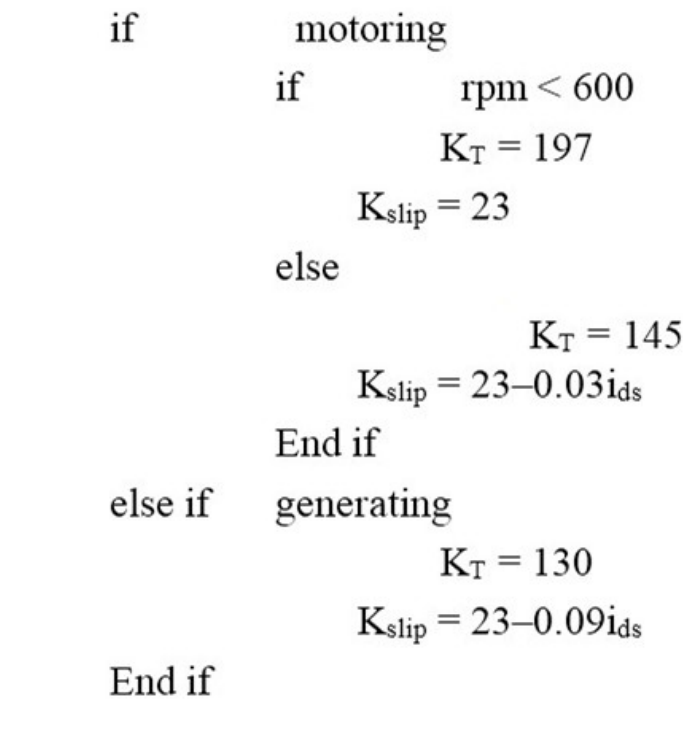
Figure 8. Off line tuning of gain